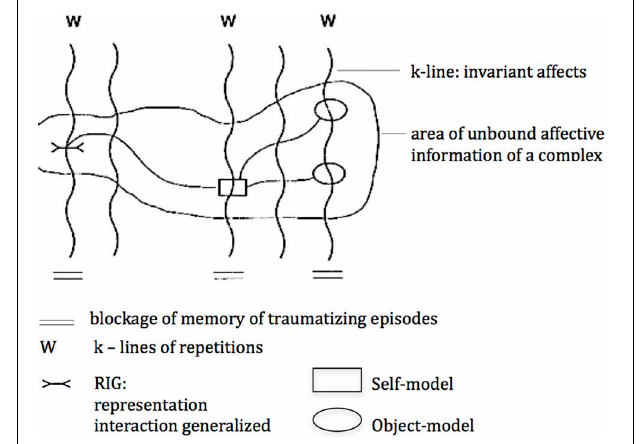
FIGURE 1 | Memory Model of conflictuous complexes according to Moser and von Zeppelin (1996).